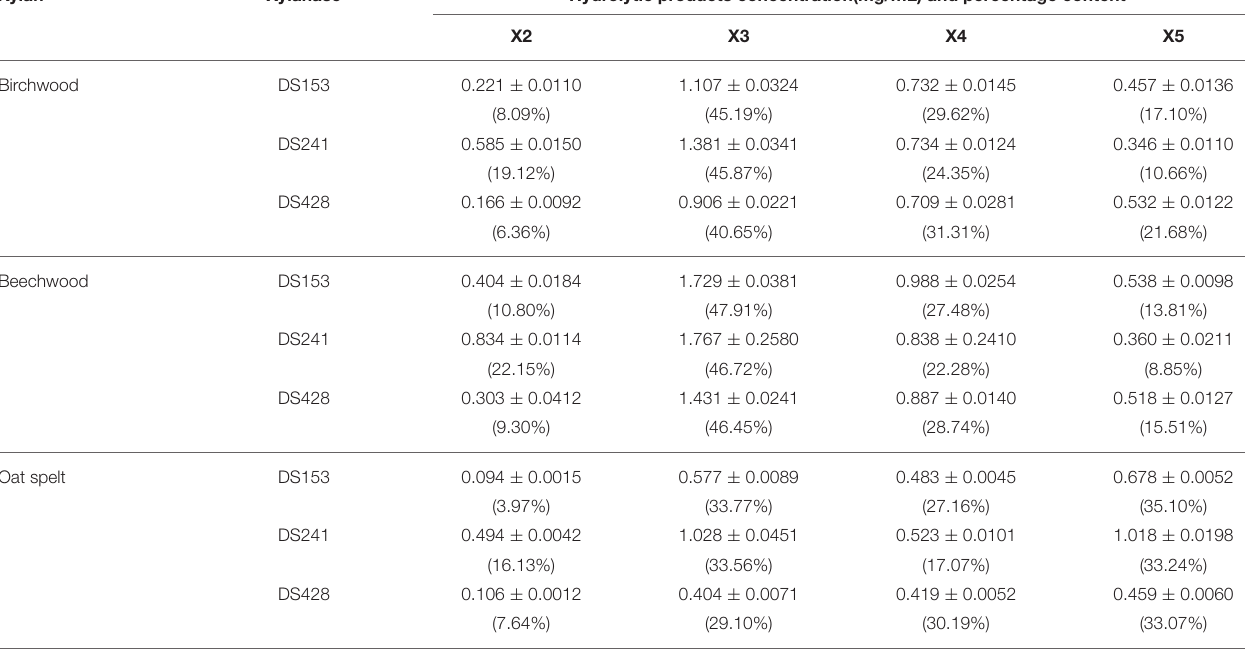
TABLE 2 | Concentration of hydrolyates of xylans.